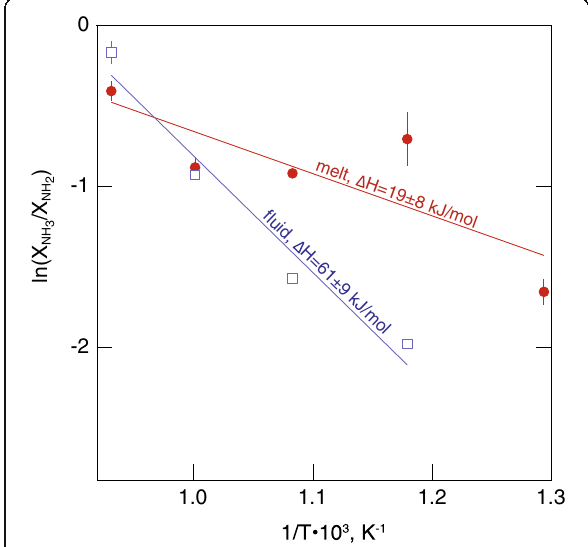
Fig. 20 NH 3 /NH 2 abundance ratio as a function of Temperature (1/ T, kelvin) in sodium silicate melts (data from Mysen and Fogel